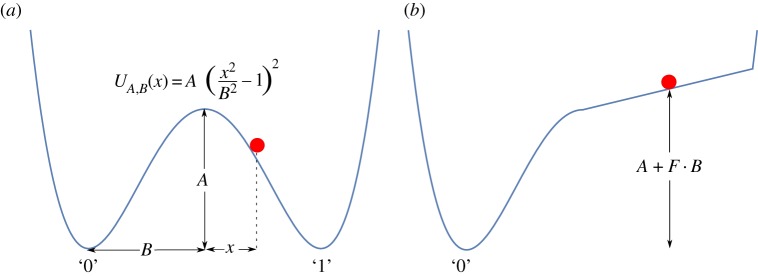
A bit as represented by a particle in a one-dimensional potential. (a) The bit in its resting state, with a barrier of height ‘A’ separating particle locations that correspond to bit values of 0 or 1. (b) A control potential as in example 2.1 is applied to erase the stored data.